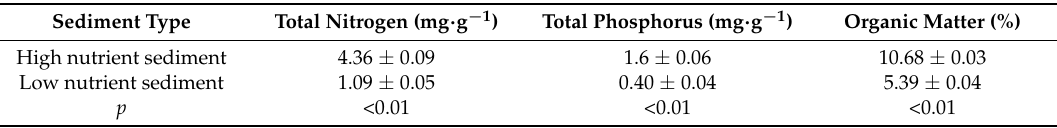
Table 1. The initial content of total nitrogen, total phosphorus and organic matter in two sediment types and significance level ( t -test) of differences between them (mean ± SD, n = 4)